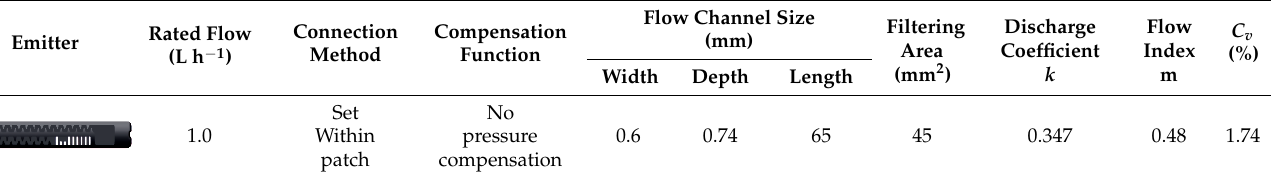
Table 1. Test emitter runner size and performance index.